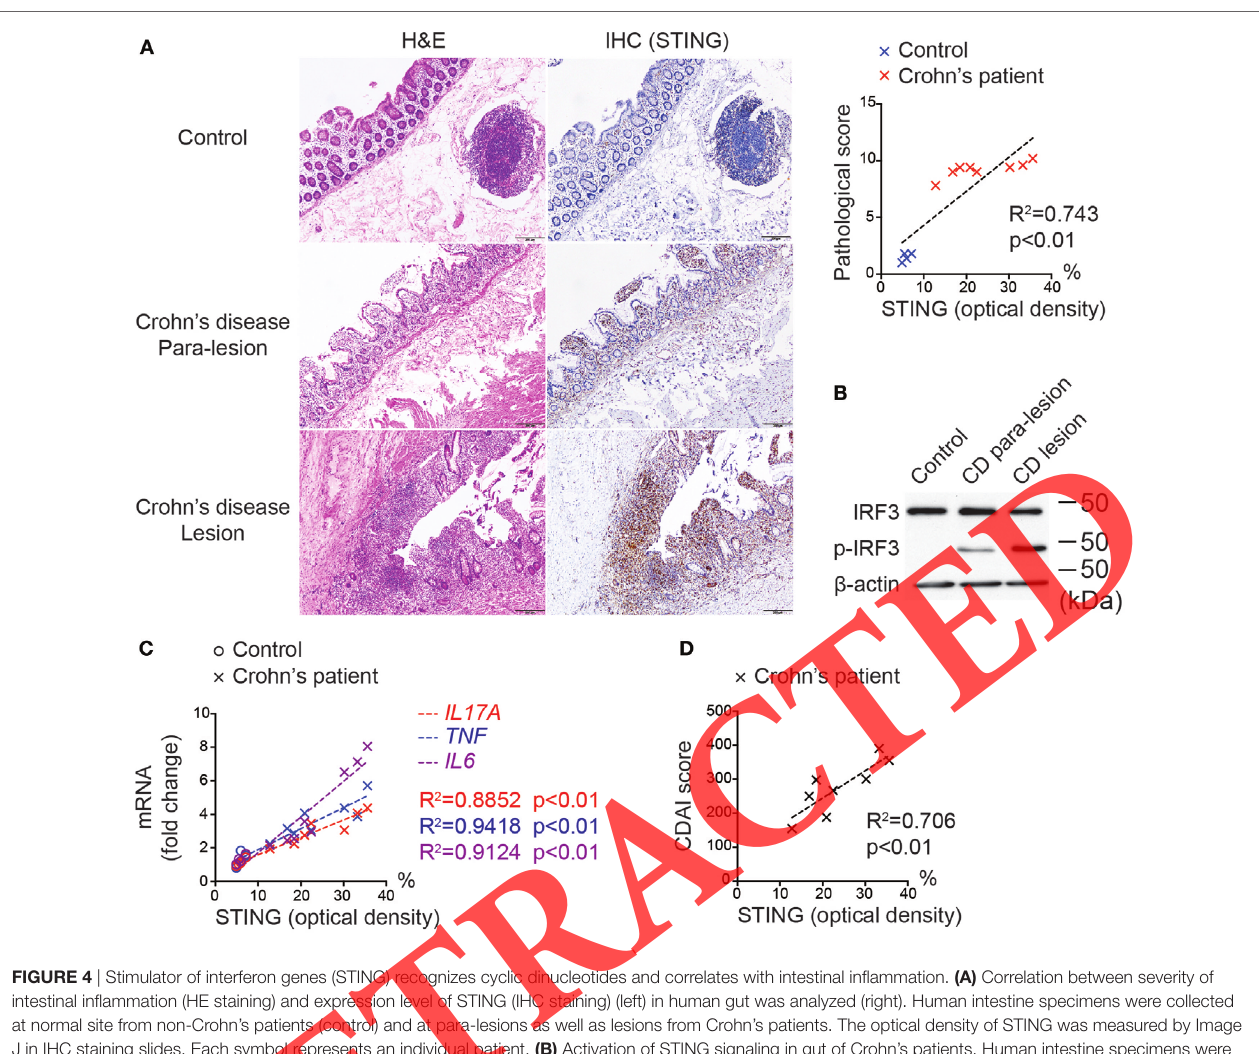
FigUre 4 | Stimulator of interferon genes (STING) recognizes cyclic dinucleotides and correlates with intestinal inflammation. (a) Correlation between severity of intestinal inflammation (HE staining) and expression level of STING (IHC staining) (left) in human gut was analyzed (right). Human intestine specimens were collected at normal site from non-Crohn’s patients (control) and at para-lesions as well as lesions from Crohn’s patients. The optical density of STING was measured by Image J in IHC staining slides. Each symbol represents an individual patient. (B) Activation of STING signaling in gut of Crohn’s patients. Human intestine specimens were collected as described in panel (a) . (c,D) Correlation of cytokine expression in tissue samples (c) and clinical CDAI score (D) to the expression level of STING. The optical density of STING was measured by Image J in IHC staining slides. Each symbol represents an individual patient. Pathological slides, 100 ×